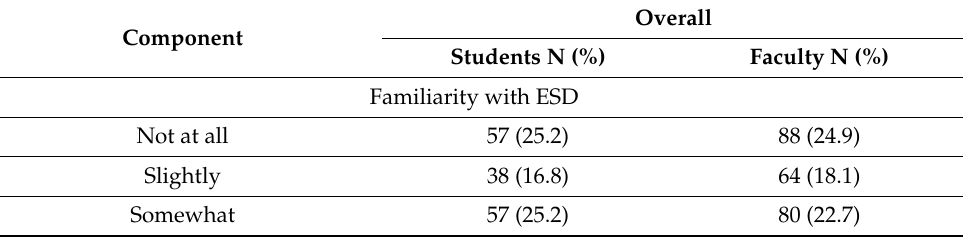
Table 2. Student and faculty familiarity with ESD and their opinions about the importance and professional responsibility for